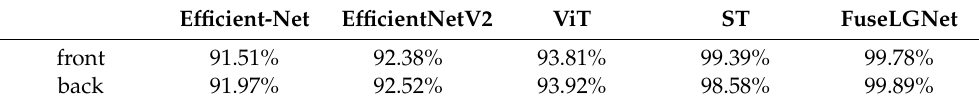
Table 2. Results from gait energy maps using the GAIT ‐ IST dataset.